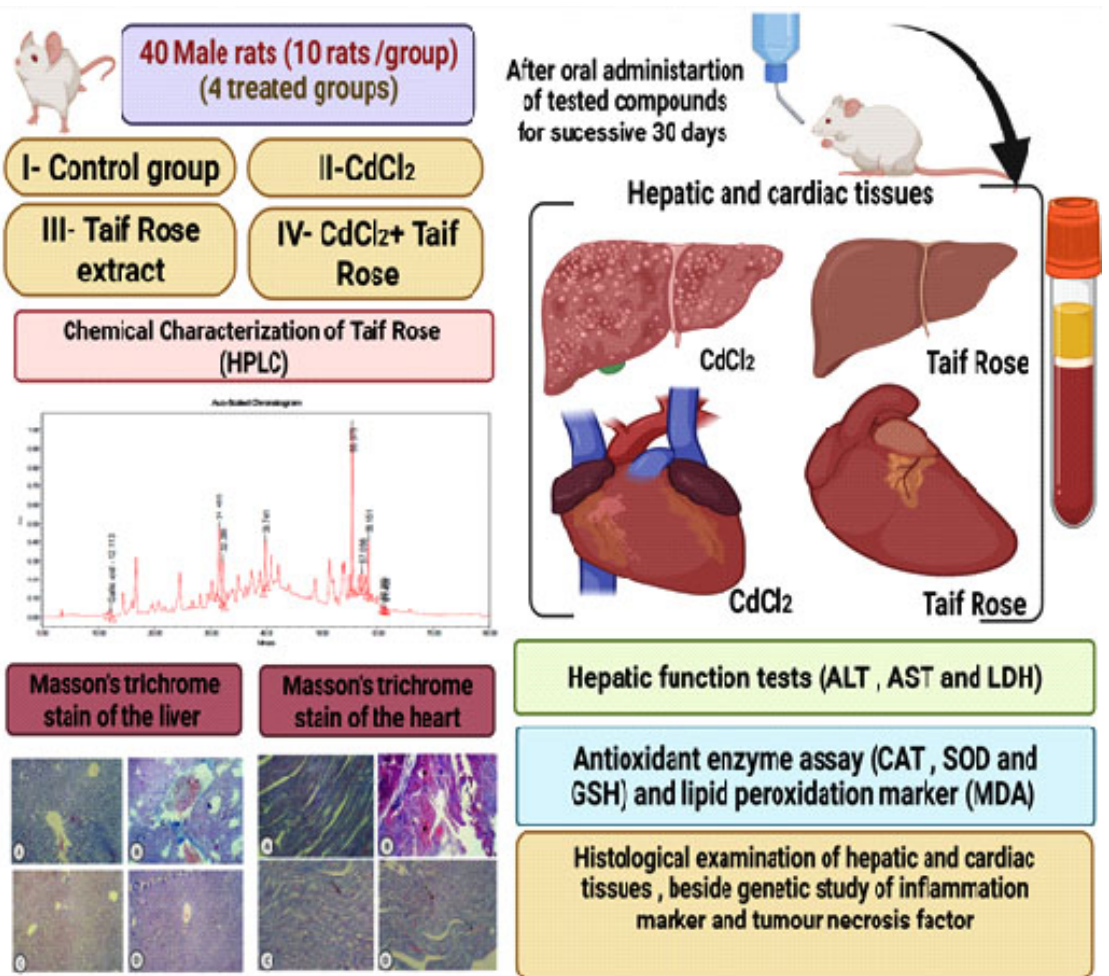
Figure 1. Experimental